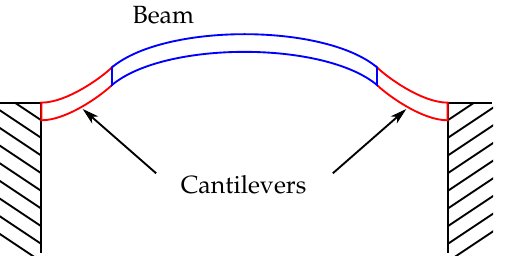
Figure 3. Beam (blue) bending due to the induced stress induced by the displacement of the connected two cantilever actuators